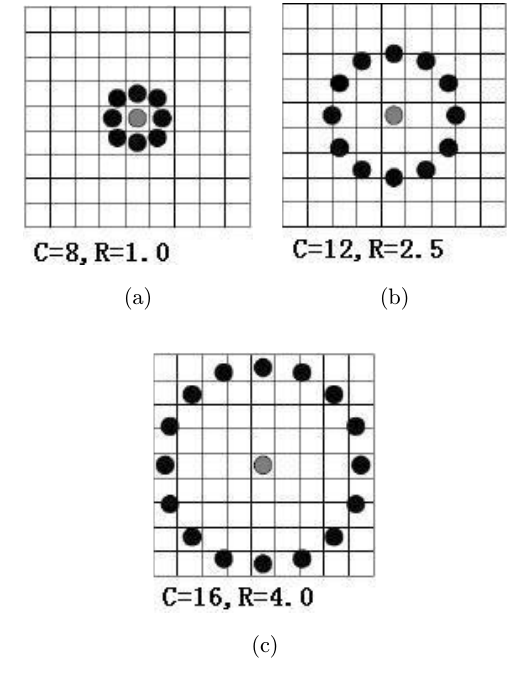
Fig. 2. Di®erent radii of